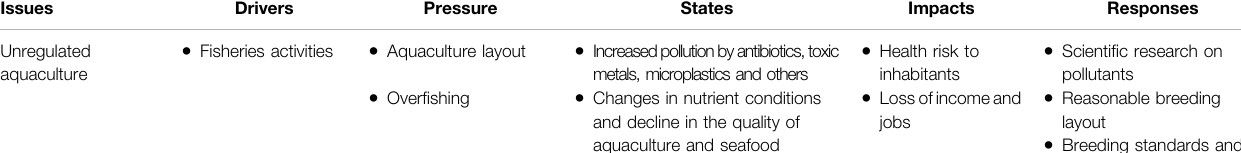
TABLE 4 | Results of DPSIR analysis: Issues-Drivers-Pressures-States-Impacts-Responses.